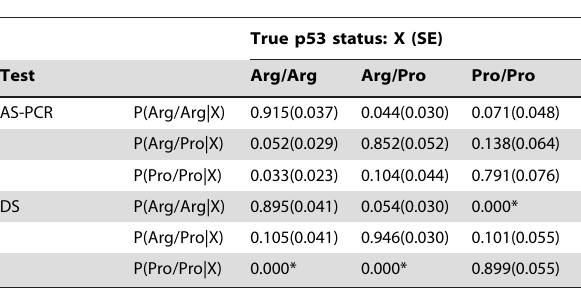
Table 6. Classification probabilities (standard errors) for